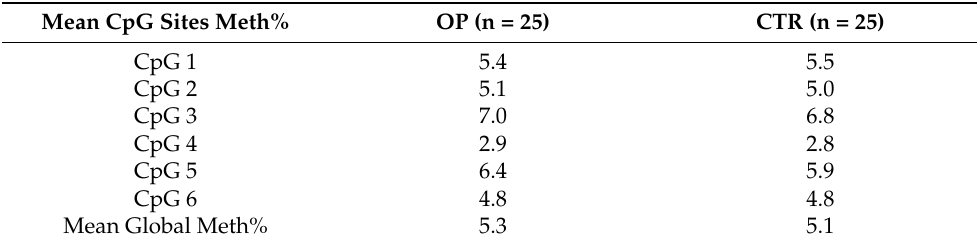
Table 4. Methylation analysis of VDR promoter CpG